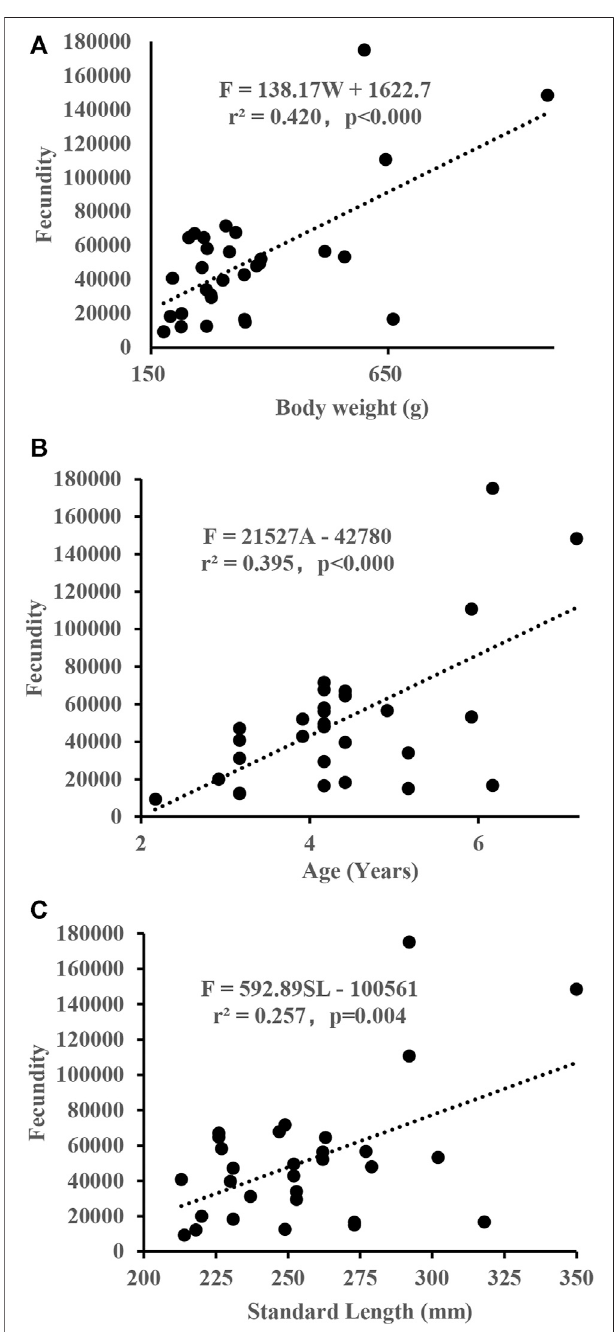
FIGURE 8 | The relationships between body weight (A) , age (B) , standard length (C) , and fecundity of S. curriculus in the western Pearl River estuary,